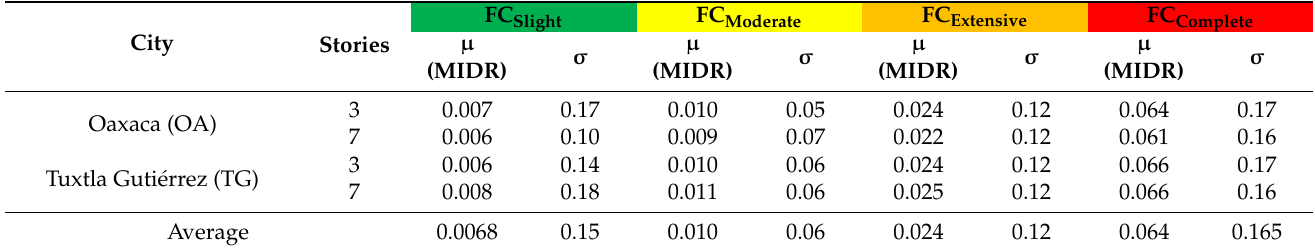
Table 11. The µ and σ of the fragility curves (FC) as a function of the MIDR for the studied